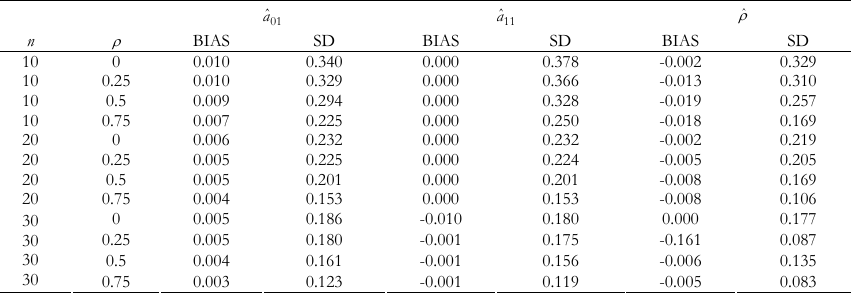
Synthesized results of the simulation referred to the ordinary least square method: N = 1000, r =